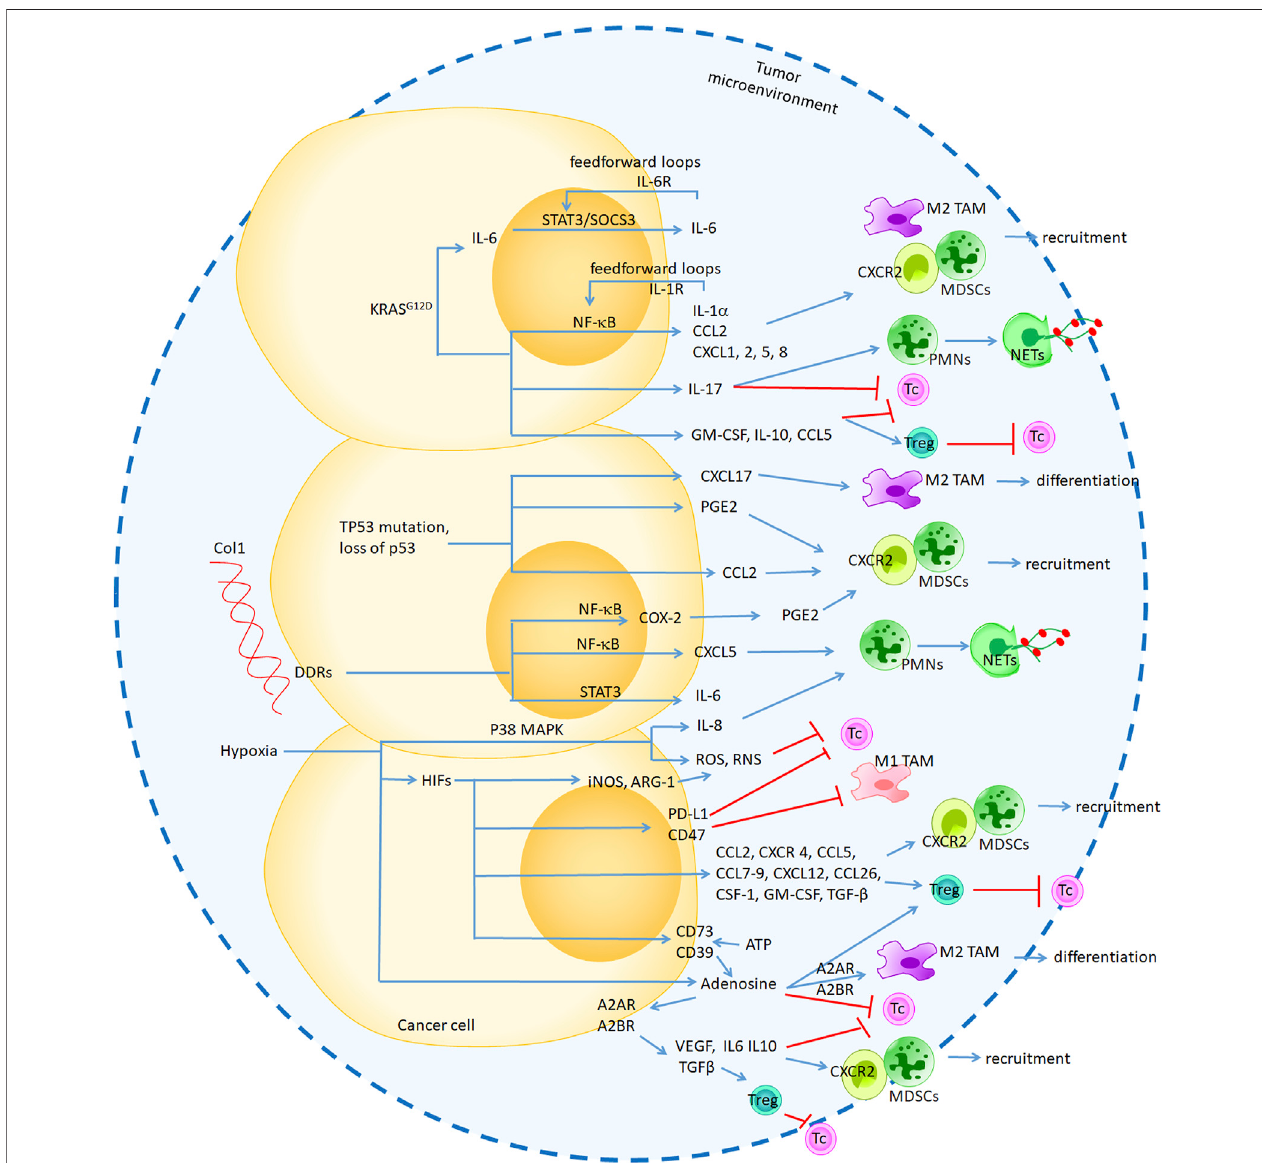
FIGURE2| Thegeneticandenvironmentalconditionsthattriggerin fl ammatorysignalingcascades,suchcyclooxygenase-2(COX-2),NF- κ BandSTAT3,toinduce secretomeproductionandin fl uencetumor-associatedmyeloidcellswithintheTME.GeneticKRASG12DandTP53mutationregulatedCXCR2,CCR5ligandssecretion through NF- κ B and STAT3 pathway to promote MDSCs accumulation and immunosuppression. Environmental collagen-DDR1 regulated CXCL5 through NF- κ B pathway to induced NETs formation. Hypoxia mediated HIF regulated CXCR2, CXCR4 and CCR5 ligands production, which induced MDSCs recruitment and Tregs generation. In additiob, HIF-regulated ROS and RNS as well as “ don ’ t eat me “ signals, which directly inhibited pro-in fl ammatory response. Hypoxia-mediated adenosine not only directly regulated M2 TAM and Tc cells by binding its receptor A2A/A2B, but also regulated cancer cells-mediated VEGF, LI-6, IL-10 and TGF- β secretion to promote DMSCs